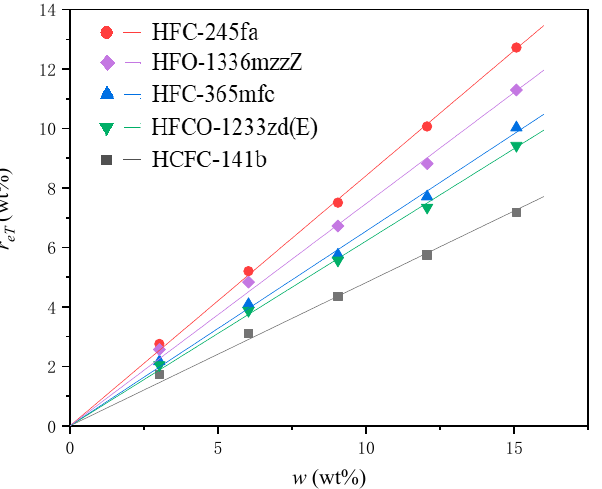
Figure 9. The relationship of the effective rate of PBA relative to the total mass of materials used, r eT , and the initial mass ratio of PBA to other blending materials in PURF, 𝑤 .